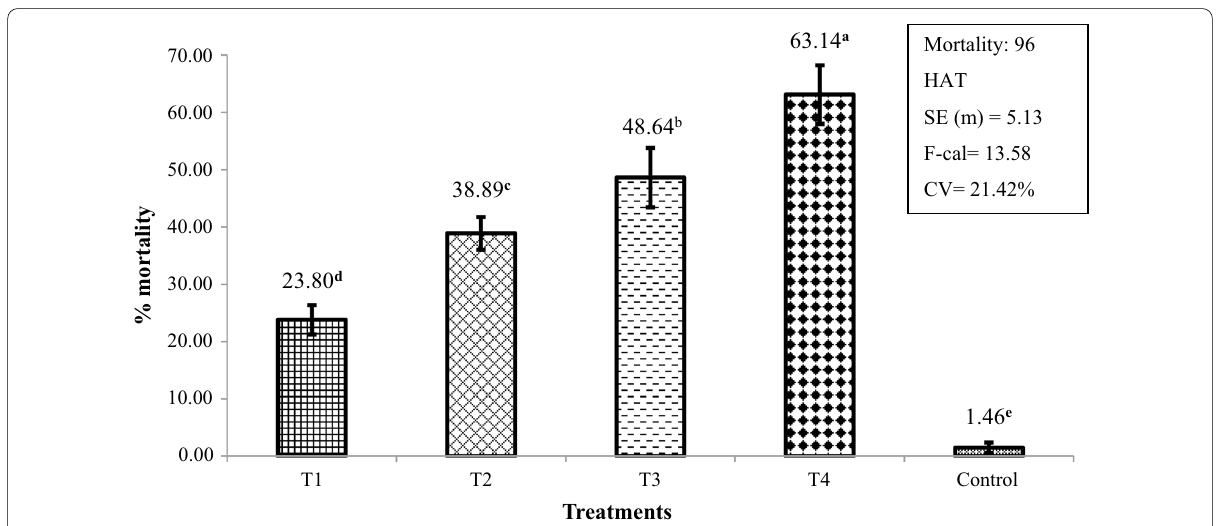
Fig. 7 Per cent mortality of aphids in open fields after treatment with spore suspension of Alternaria alternata